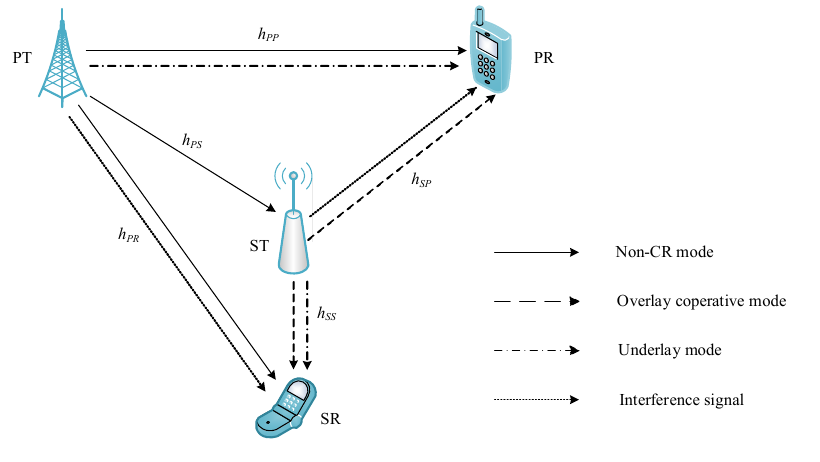
Figure 1. System Figure 1. System model.